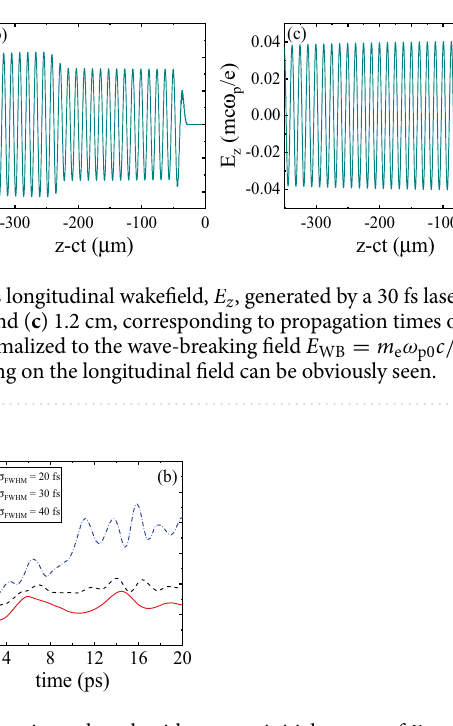
Figure 4. ( a ) Maximum energy gain (cid:31) E of a witness bunch with average initial energy of E 0 = 15 MeV injected at optimal initial distance from the driving laser pulse, plotted versus the acceleration distance for three pulse durations at a fixed peak pulse power of 0.5 TW. The blue, black, and red colors denote the 20 fs, 30 fs, and 40 fs pulse durations, respectively; ( b ) The corresponding bunch emittance ε N, x as a function of the propagation